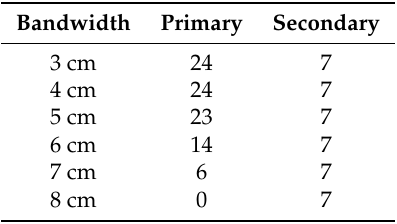
Clustering with various bandwidths. All conductor spans from the Hounslow dataset were